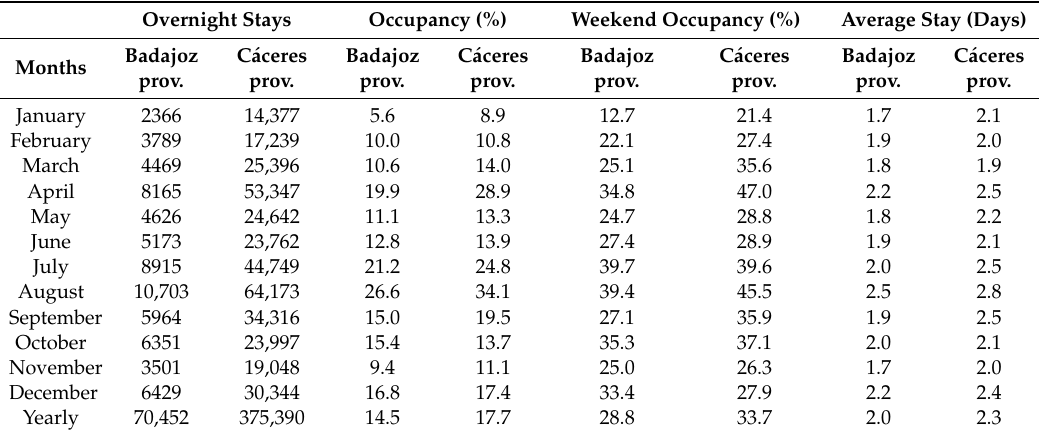
Table 4. Tourist indicators: seasonal nature, occupancy, and average stay